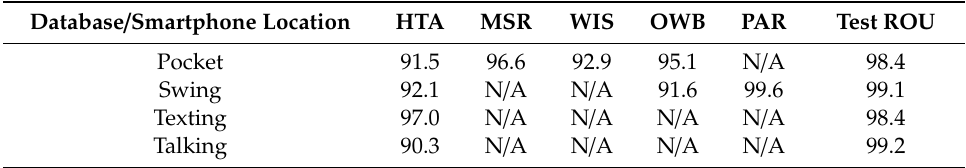
Table 12. Test accuracy results after hyperparameter tuning when training on the TrainROU dataset with the CNN / LSTM architecture while using accelerometer measurements